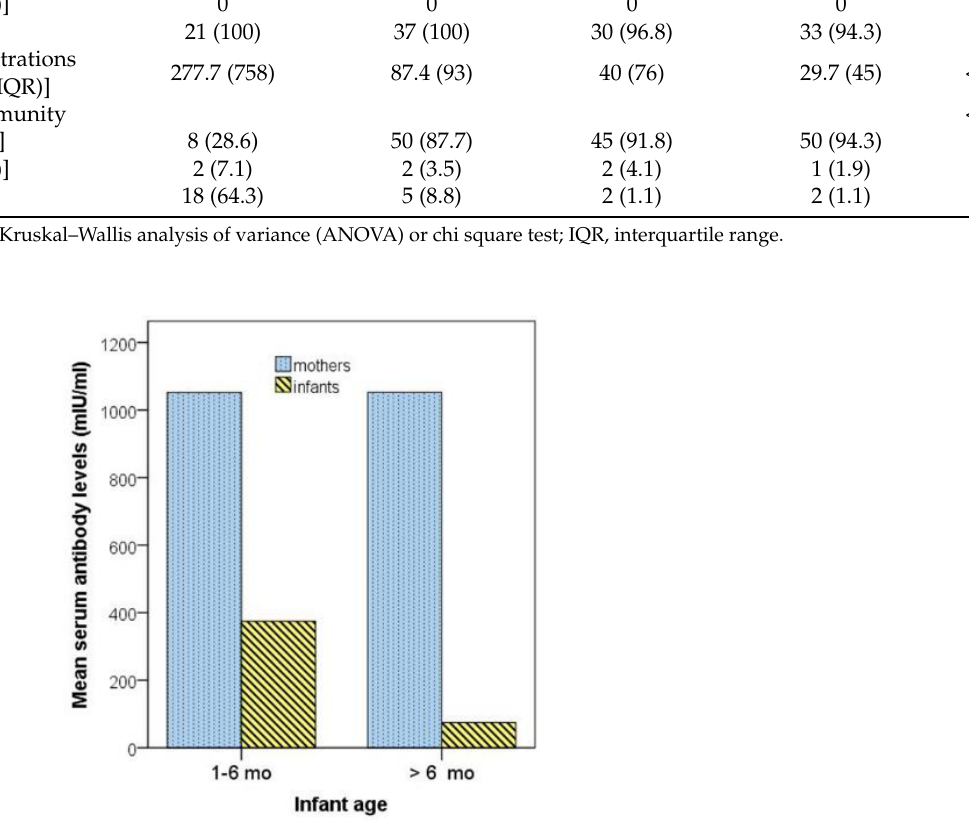
Figure 1. Serum measles antibody levels in two infant subgroups with age 1–6 months and >6 months, respectively, and their respective mothers. mo, months. In addition, the proportion of mothers and infants of the four age-related subgroups with antibody levels above or below the protective threshold (>200 mIU/mL or <150 mIU/mL, respectively) are depicted in Figure 2. Both Figure 2 and Table 2 show that mea- sles antibody levels were above the protective threshold in the vast majority of mothers (97.6%), while being below the protective threshold in the majority of infants (81.8%). Mothers with a history of measles infection had higher antibody levels than mothers with vaccine-induced immunity (median [IQR], 1322 [923] mIU/mL vs. 1086 [876] mIU/mL), but the difference was not significant ( p = 0.158). Moreover, there was no correlation be- tween maternal antibody levels and maternal age (r = 0.052, p = 0.576).